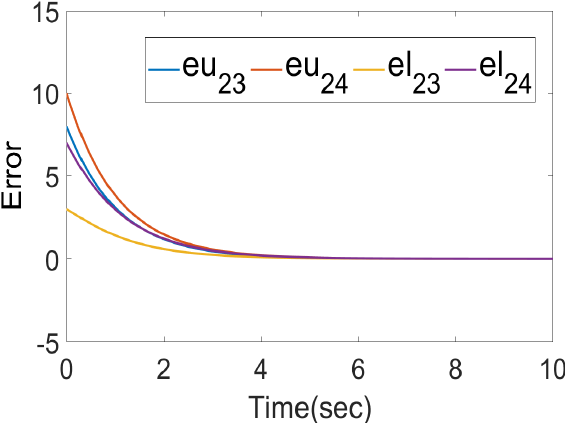
Figure 6. The error between the observer and the original system of the second manipulator.